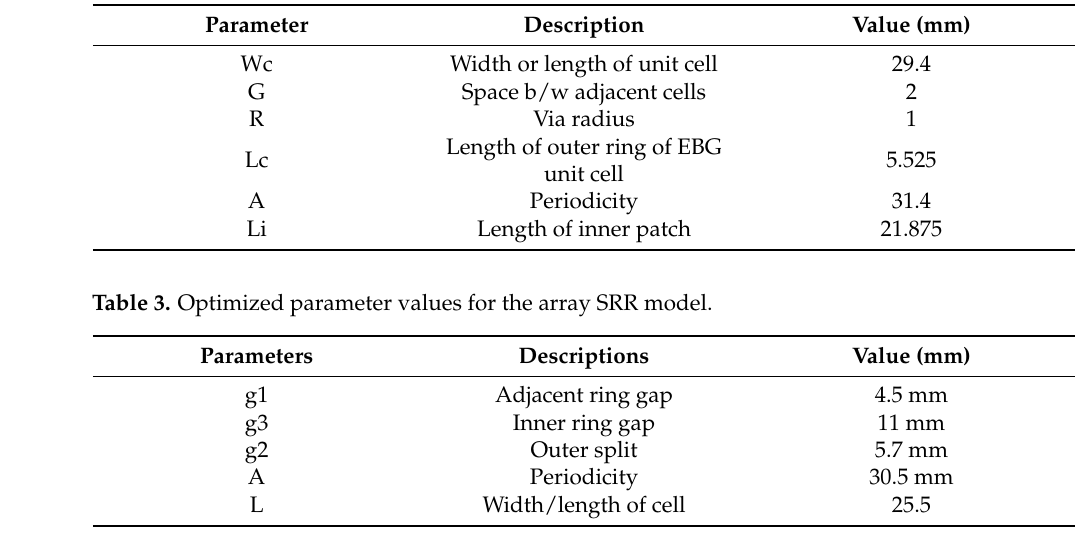
Figure 3. In-phase reflection of EBG unit cell. Table 2. Optimized parameter values for the array EBG model.